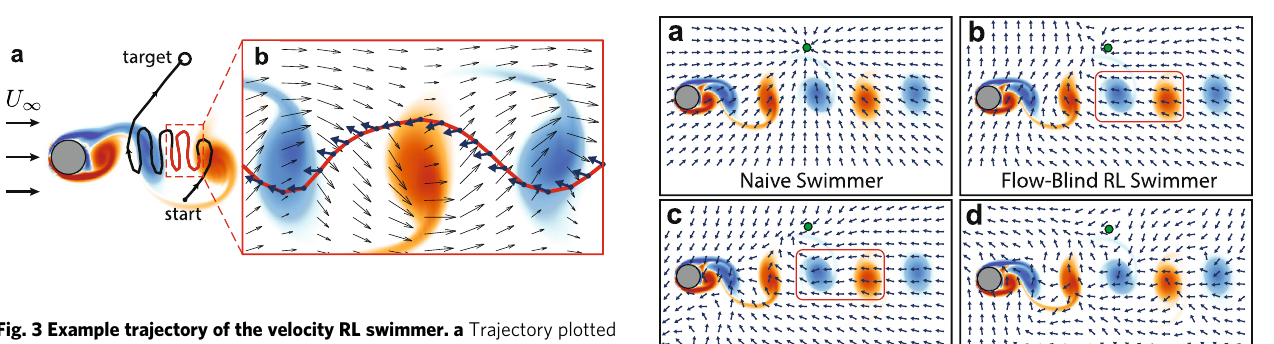
Fig. 3 Example trajectory of the velocity RL swimmer. a Trajectory plotted in a cylinder- fi xed frame, showing the swimmer successfully navigate from its starting location to the target. b Segment of this trajectory plotted in a wake-stationary frame of reference on top of the background fl ow fi eld, which highlights the swimmer exploiting low-velocity regions in the cylinder wake to swim upstream. The swimming direction is plotted at each time step along the trajectory, revealing that this RL swimmer adjusts it swimming direction in response to the changing background fl ow, enabling time-ef fi cient navigation.